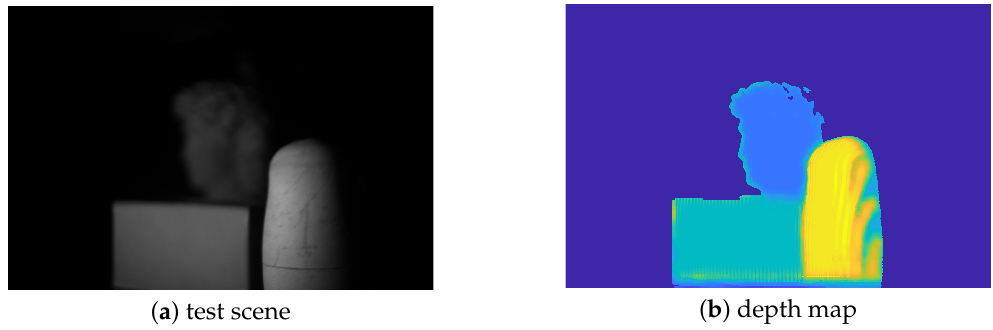
Figure 7. Photograph of the test scene and the global coarse depth map. ( a ) Test scene; ( b ) depth